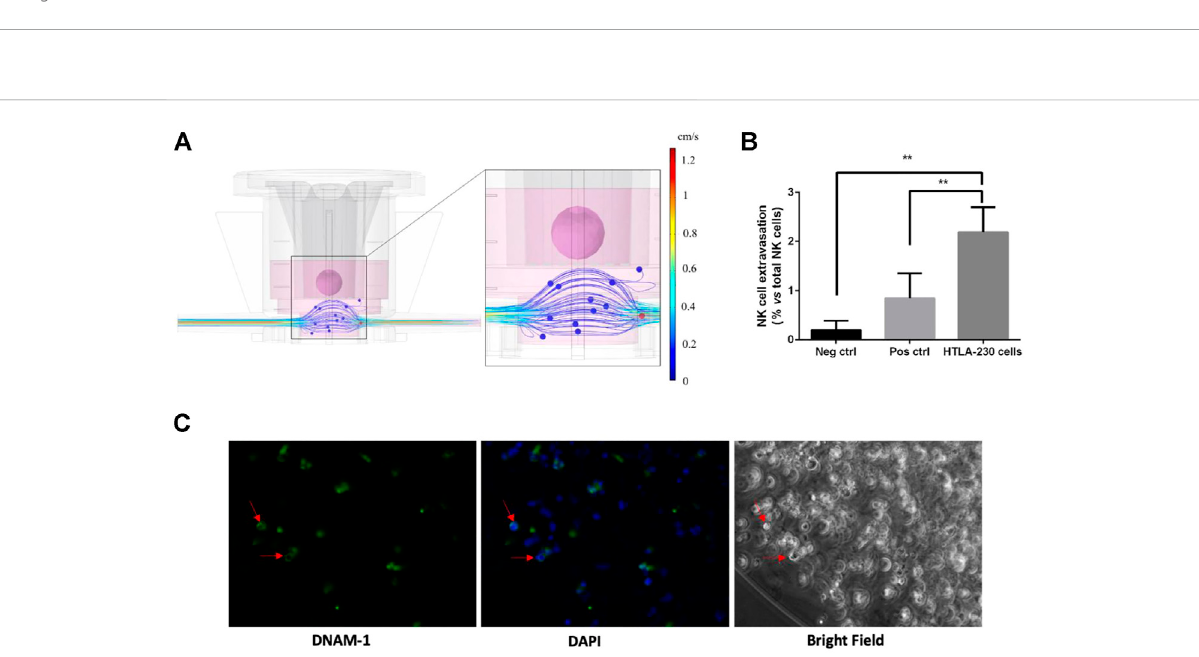
FIGURE 6 Dynamic culture with circulating NK cells (4 h coculture). (A) CFD simulation of the fl uid velocity pro fi les within the organ on chip and the fl uid fl ow-driven immunecells trajectories. (B) Tumor-speci fi cNK cell extravasation (neg ctrl: DMEM w/o supplements; pos ctrl: alginate gels w/o HTLA- 230 cells, plus 30% FBS; HTLA-230 gels with standard 10% FBS) ( n = 6). (C) NK cell in fi ltration within the gel, as indicated by DNAM-1-positive cells highlighted by red